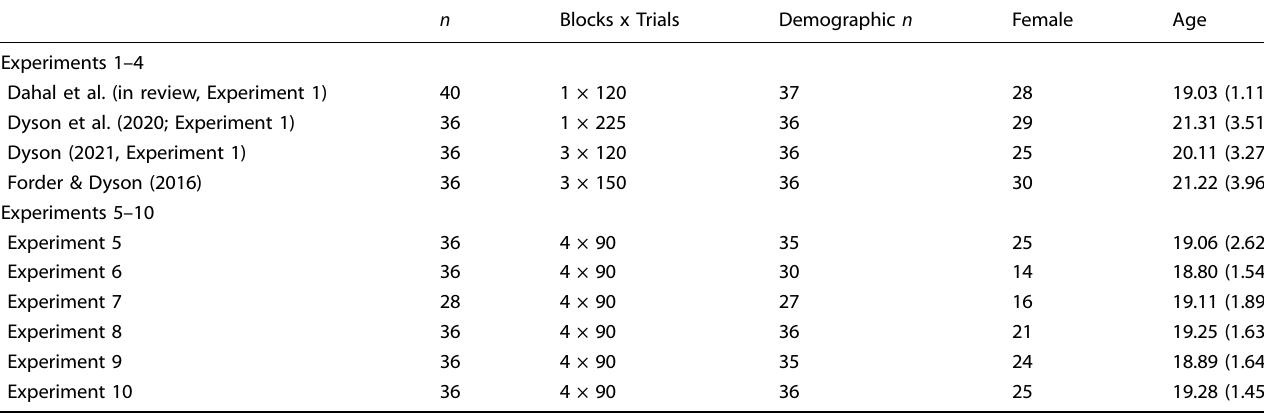
Table 1. Summary statistics from those individuals who volunteered demographic information across experiments 1 – 10. Standard deviation in